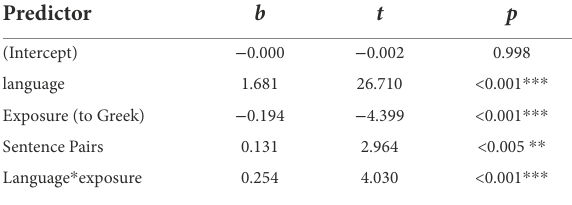
TABLE 5 Coefficients and significance values for the final, best fitting linear mixed effects model.